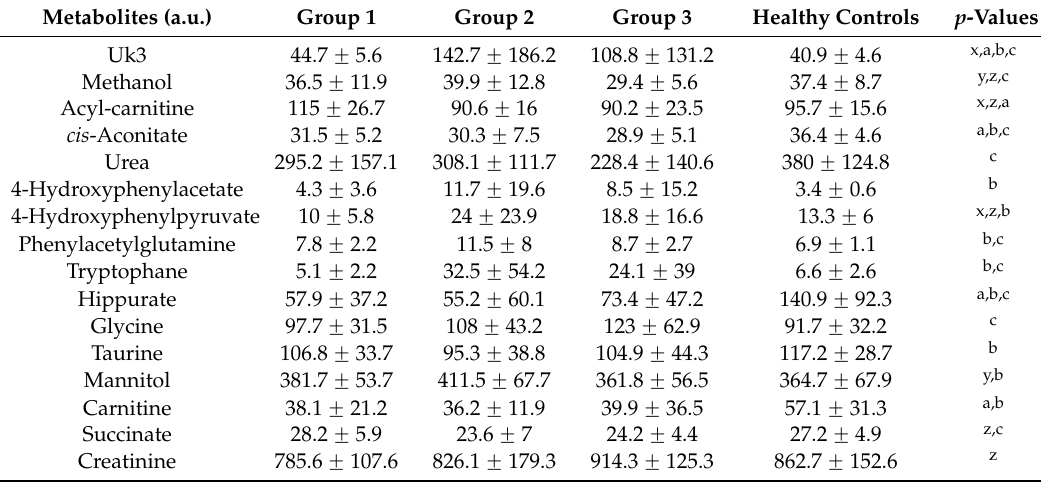
Table 4. Urinary metabolites and clinical